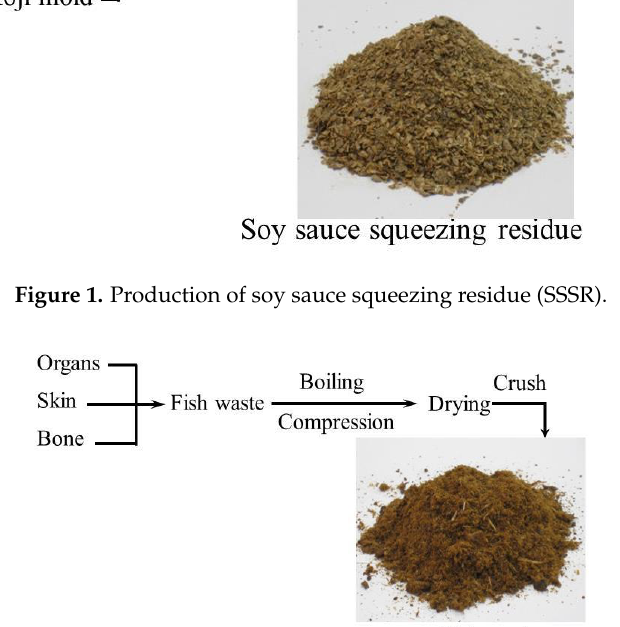
Figure 2. Production of fishmeal.